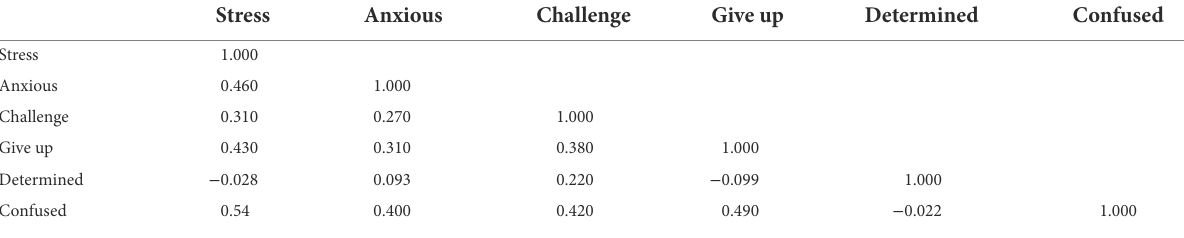
TABLE 6 Pairwise correlations of challenge, stress, anxiety, giving up, determination, and